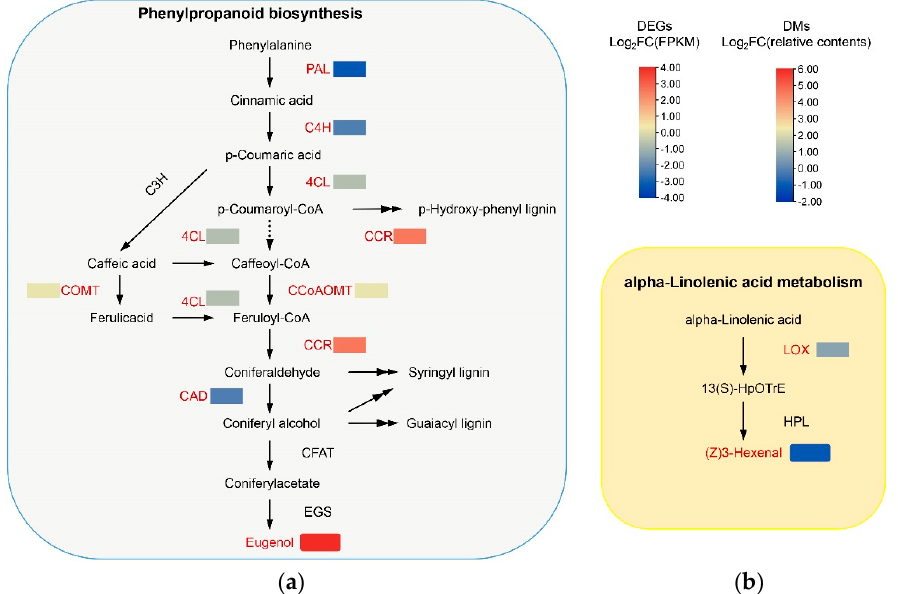
Figure 7. Change fold of DEGs and DMs in TH compared to TL. ( a ) Phenylpropanoid biosynthesis: 4CL, 4-coumaroyl-CoA ligase; C3H, p -coumarate-3-hydroxylase; COMT, caffeic acid O-methyltransferase; CCoAOMT, caffeoyl-CoA O-methyltransferase; CFAT, coniferyl alcohol acetatyltransferase; EGS, eugenol synthase; ( b ) alpha-Linolenic acid metabolism: HPL, hydroperoxide lyase; 13(S)HpOTrE, (9Z,11E,15Z)-(13S)-Hydroperoxyoctadeca-9,11,15-trienoate. Other abbreviations were as shown in Figure 4. Red represented the mapped DEGs and DMs. Dotted arrow represented unknown steps; double arrows represented multiple steps.